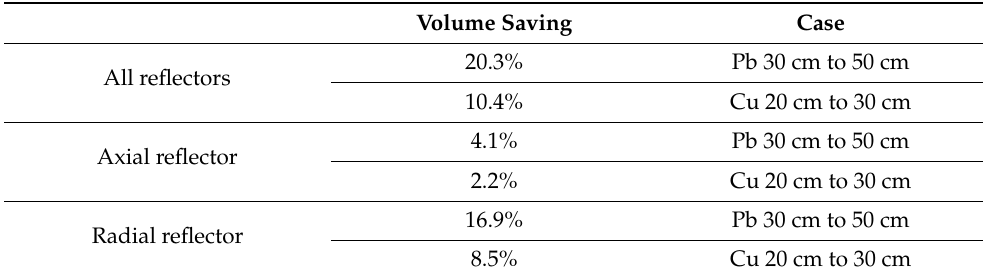
Table 3. Study of potential volume savings resulting from an increase in the reflector thickness at different